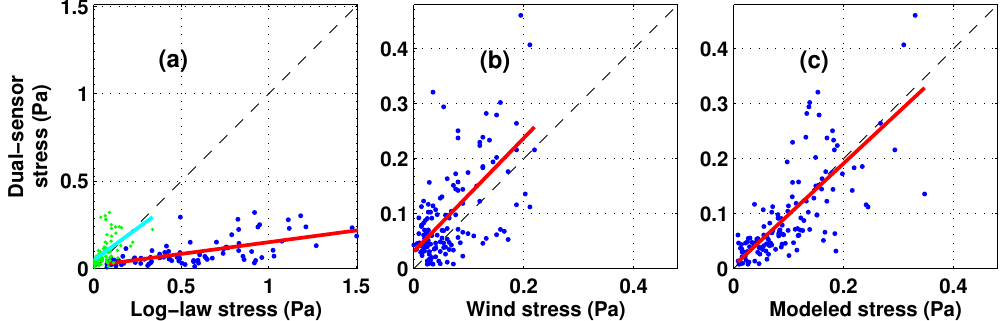
Figure 7. Comparison of the direct estimates of near-bed Reynolds stress with ( a ) log-law estimates of bottom stress (blue dots and red line correspond to log-law in Equation (1); green dots and cyan line correspond to the log-law estimates that take stratification into account by Equation (4) [8]); ( b ) wind stress at the sea surface; and ( c ) bottom stress based on the model [12]. Dashed black lines show the one-to-one relationships; red and cyan lines show the linear least squares